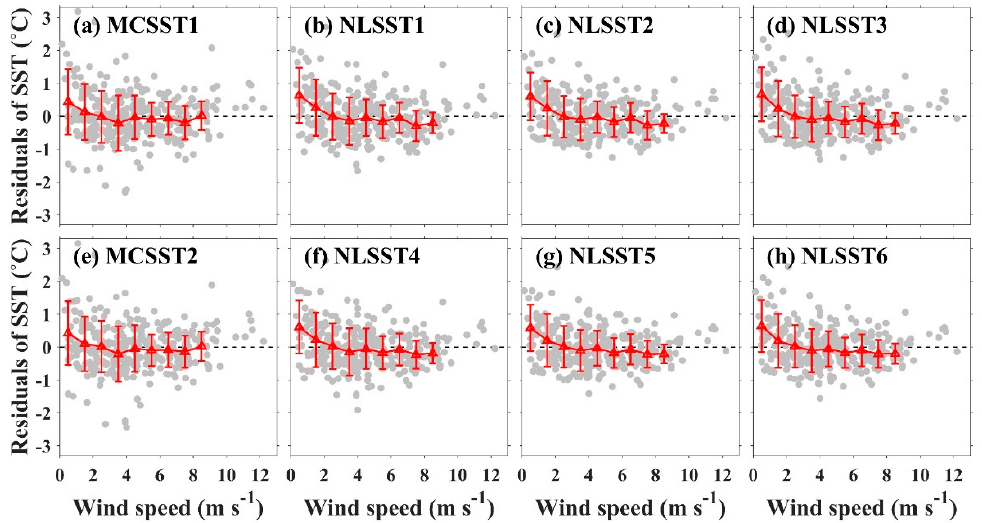
Figure 11. Comparison of residuals (Landsat 8 OLI / TIRS SST – buoy SST) using ( a ) MCSST1, ( b ) NLSST1, ( c ) NLSST2, ( d ) NLSST3, ( e ) MCSST2, ( f ) NLSST4, ( g ) NLSST5, and ( h ) NLSST6 with wind speed, where the red points and bars represent the mean value and standard deviation of SST errors for each interval,